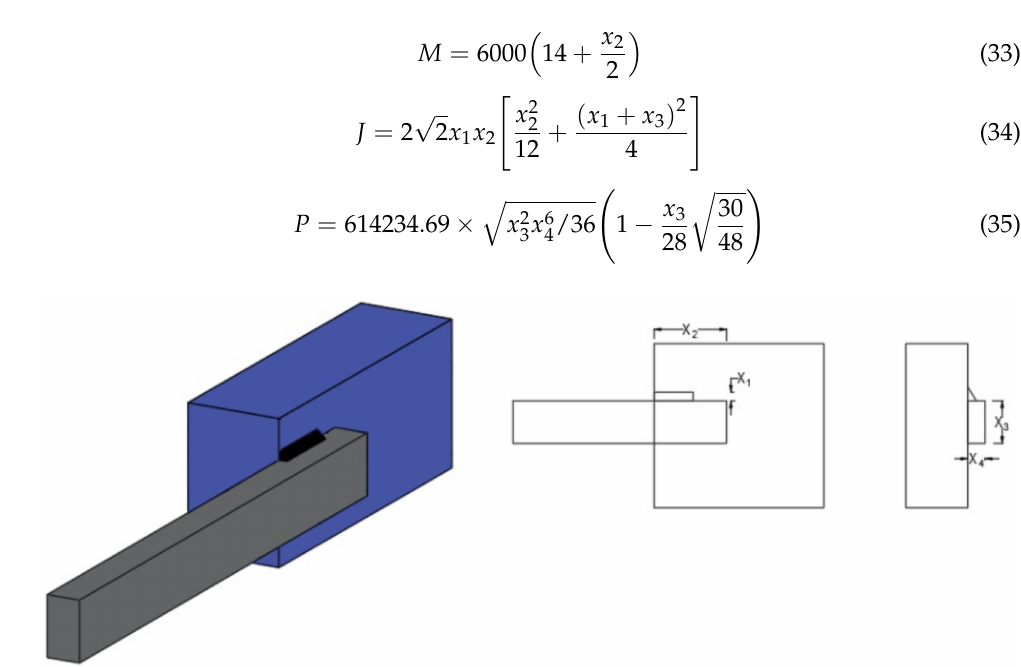
Figure 13. WBD problem [56].